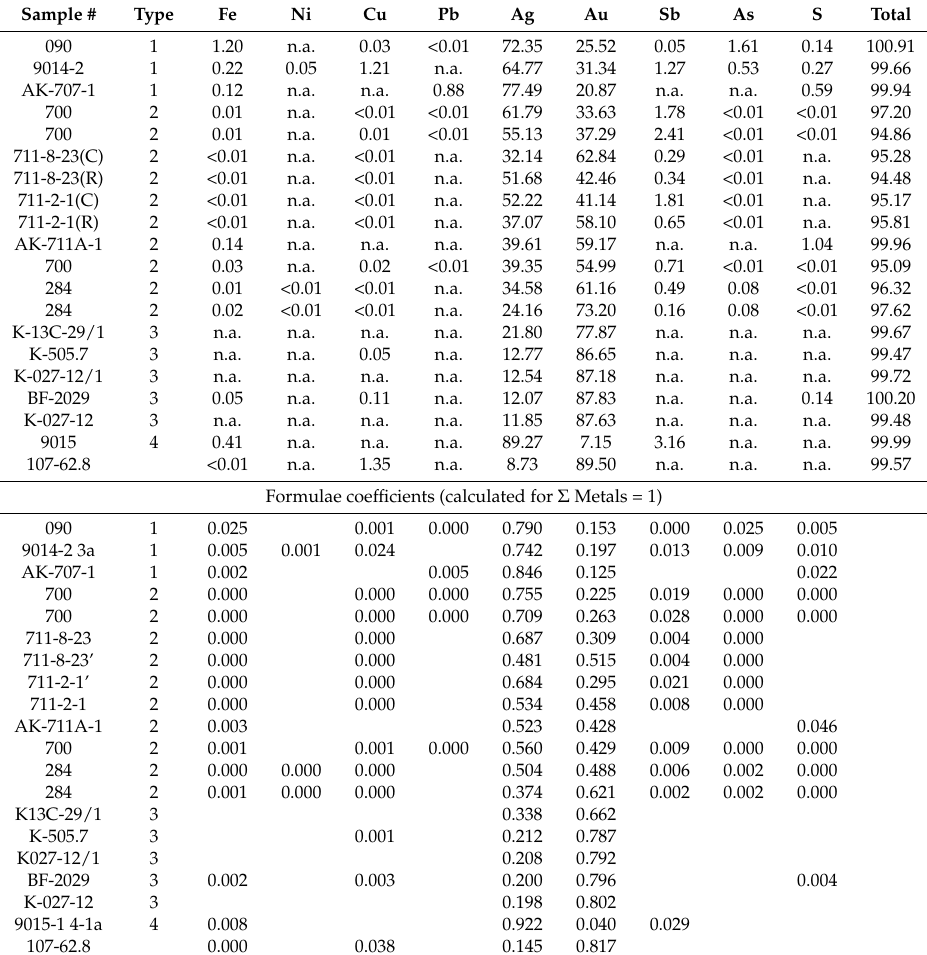
Table 3. Electron microprobe data in wt.% for native gold and silver from the Oleninskoe and Nyal’m (s ample # 62.8–107) deposits.